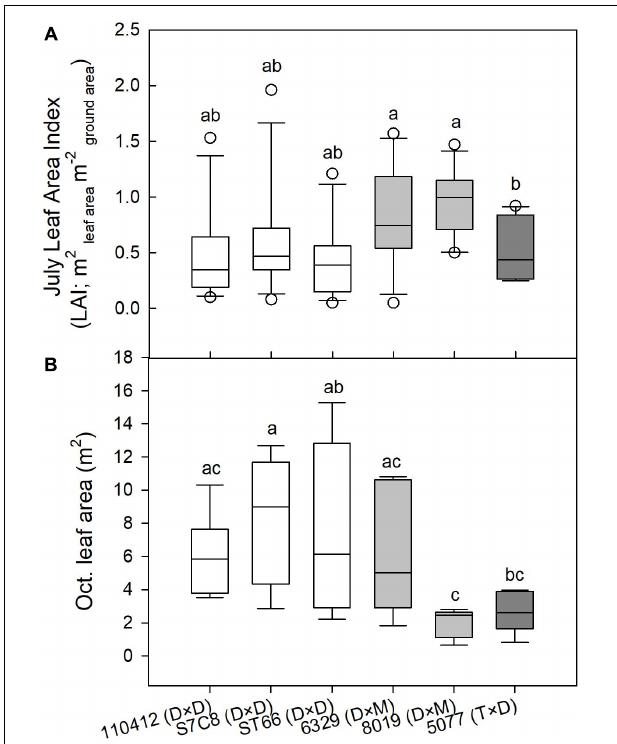
FIGURE 1 | (A) Plot-level July leaf area index (LAI; m 2 m − 2 ) at the Coastal Plain site and (B) individual tree leaf area (m 2 ) estimated from tree harvests in October at the Coastal Plain site for P. deltoides × P. deltoides taxa (D × D; white), P. deltoides × P. maximowiczii taxa (D × M; light gray), and P. trichocarpa × P. deltoides taxa (T × D; dark gray). Varietals with different letters in each panel differ significantly at p <